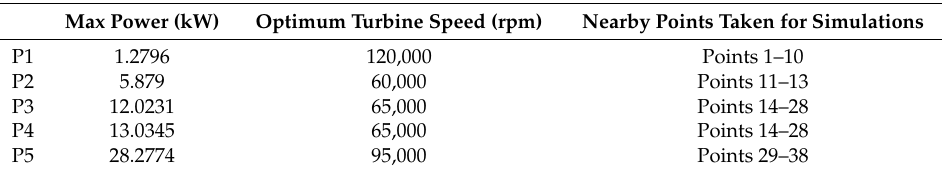
Table 3. Optimum Turbine Speeds Benchmark.